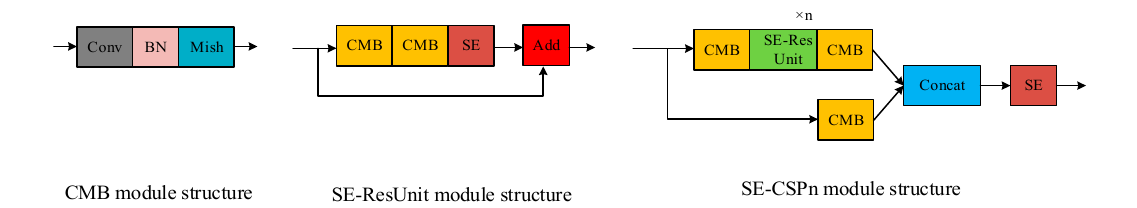
Figure 3. YOLOv4 network structure with SE module.